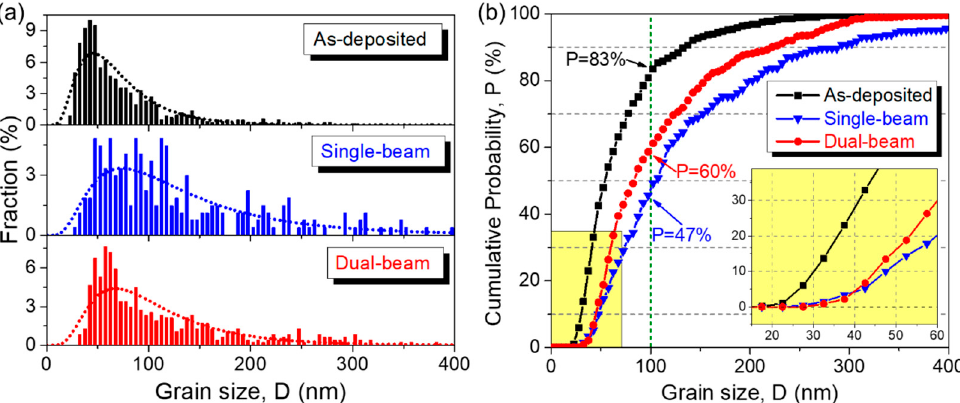
Figure 4. ( a ) Grain size (equivalent diameter) histograms for as-deposited (black), single-beam irradiated (blue), and dual-beam irradiated (red) sample. ( b ) Cumulative probability versus grain size.